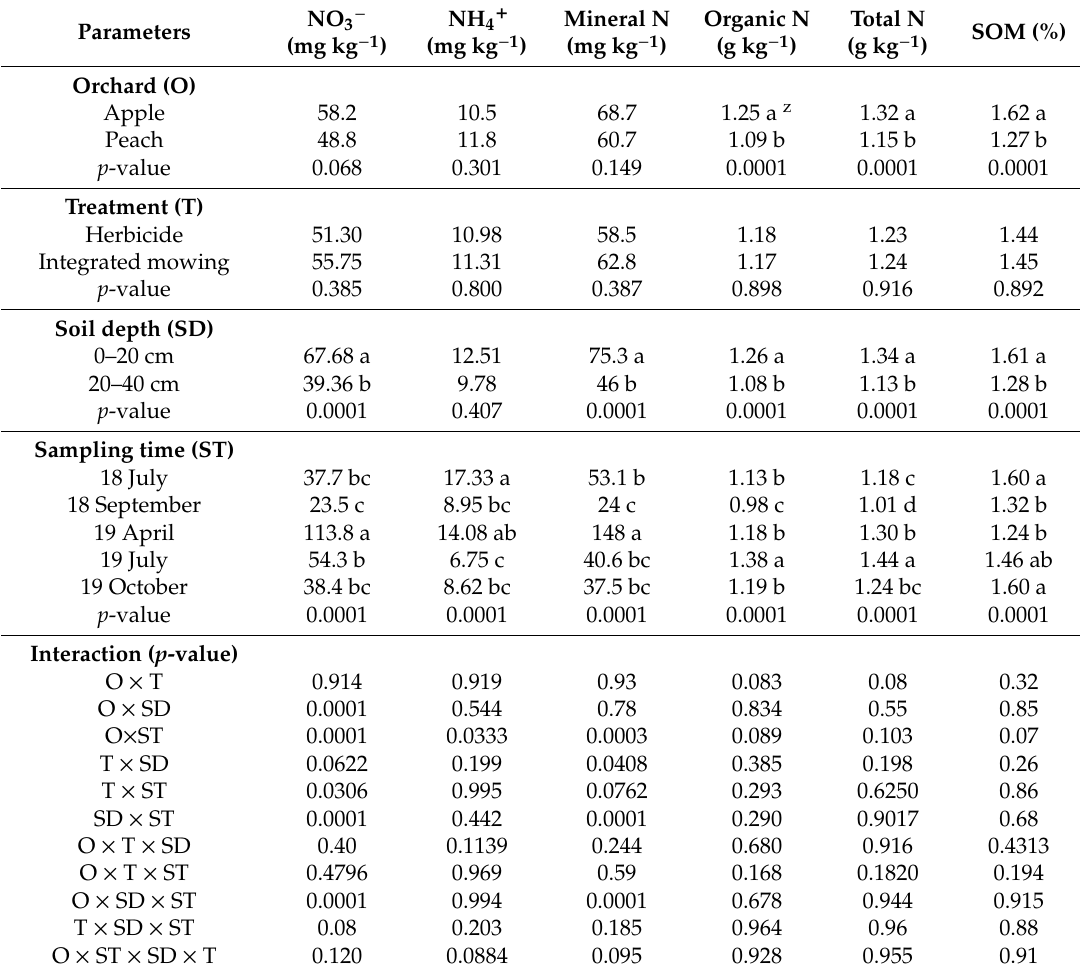
Table 1. Two-way ANOVA for the e ff ects of treatment, orchard, soil depth, sampling time, and their interactions on soil N variables and soil organic